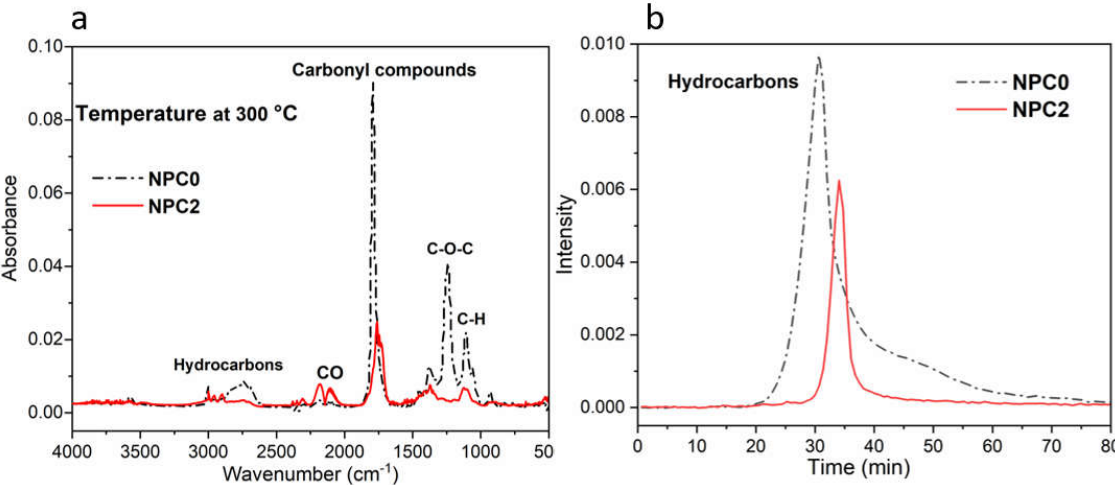
Figure 8. Curves from TGA/FTIR test for NPC0 and NPC2: ( a ) FTIR spectrum for volatiles at 300 °C; ( b ) evolution of hydrocarbons component at the whole heating process.